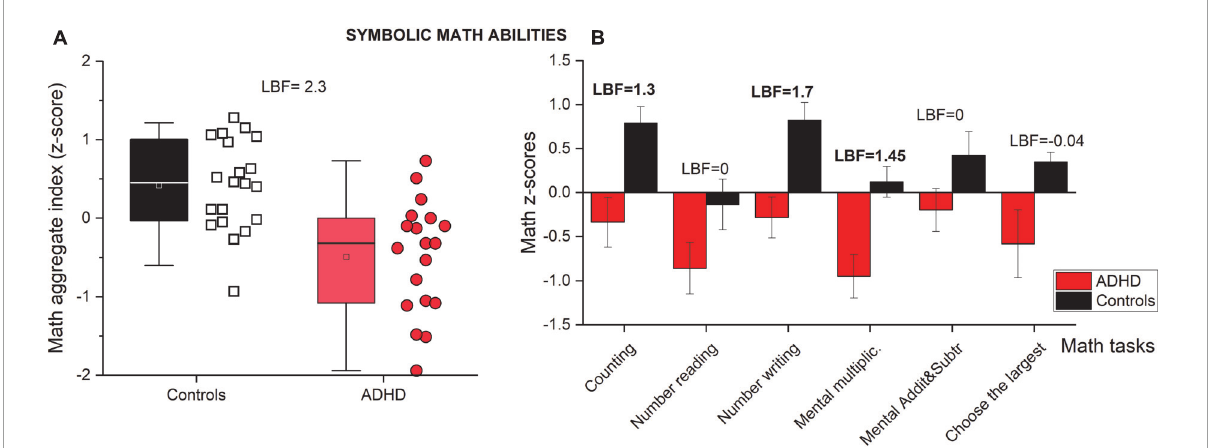
FIGURE2 Mathematical abilities. (A) Whisker plots reporting mathematical abilities as an aggregate index (average z -score across six math tests). Color and Whisker conventions as before. (B) Participants’ average math scores divided into the six different math tests for controls (black) and ADHD groups (red) . Error bars report ± 1 s.e.m. Strong evidence (LBF > 1) in favor of the alternative hypothesis (difference between groups) are indicated in bold.